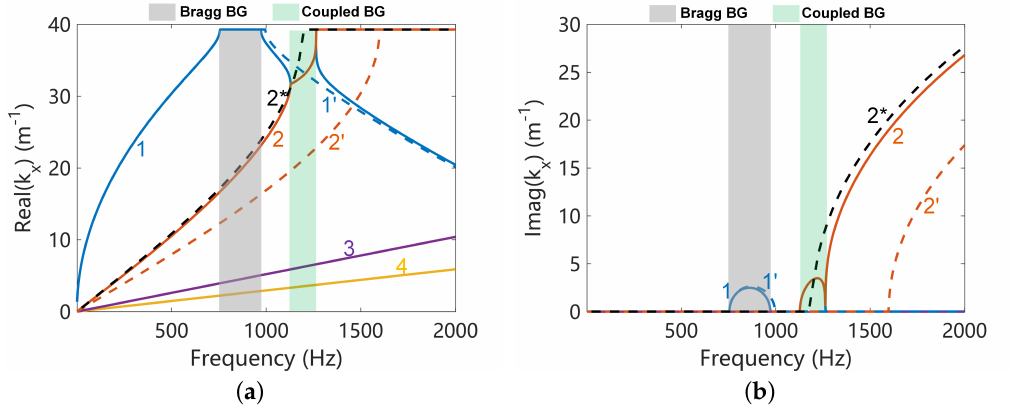
Figure 6. Dispersion curves along the x direction of L-network with L = 0.1H, ( a ) shows the real part of k x and ( b ) shows the imaginary part of k x . Waves 1 and 2 are electromechanical waves. The dash lines 1’ and 2* refer to uncoupled disconnected flexural and electric waves respectively. The dash line 2’ refers to the uncoupled blocked electric